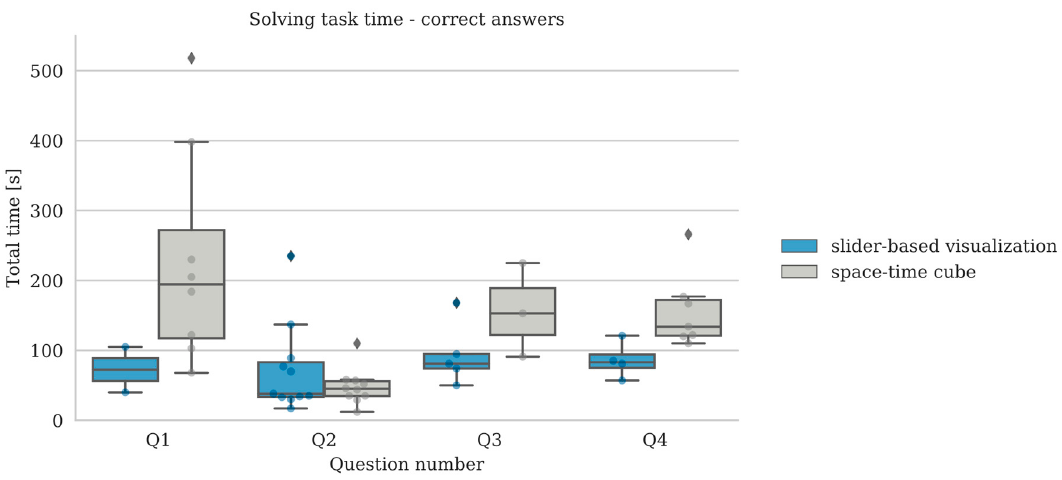
Figure 9. Solving task time to successfully complete the benchmark tasks. The users gave correct answers to the questions.